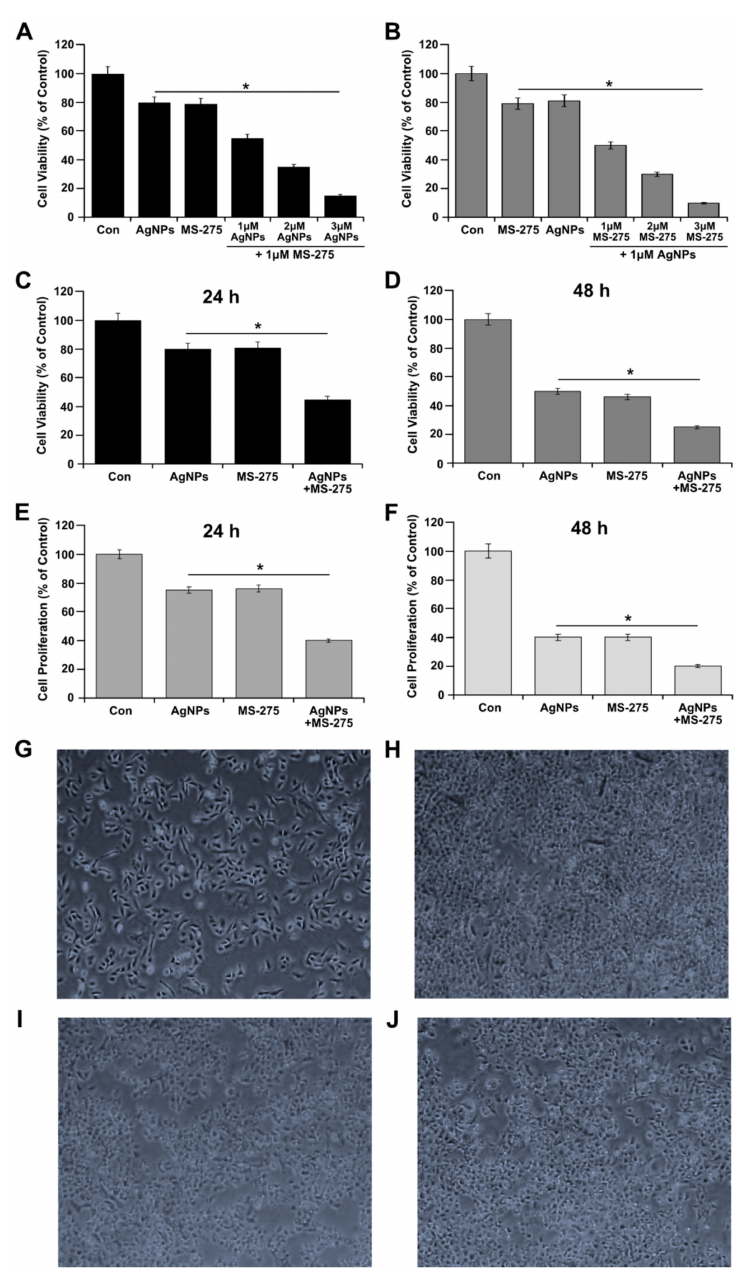
Figure 4. Effect of combination of AgNPs and MS-275 on cell viability in A549 cells. ( A ) A549 cells were incubated with a combination of different concentrations of AgNPs (1–3 µ M) and a fixed concentration of MS-275 (1 µ M) for 24 h and cell viability was measured using CCK-8. ( B ) A549 cells were incubated with a combination of different concentrations of MS-275 (1–3 µ M) and a fixed concentration of AgNPs (1 µ M) for 24 h. ( C , D ) Cell viability and ( E , F ) cell proliferation was determined in A549 cells were incubated with AgNPs (1 µ M), MS-275 (1 µ M), or a combination of AgNPs (1 µ M) and MS-275 (1 µ M). ( G – J ) Cell morphology was assessed under a light microscope. (G-control; H-AgNPs; I-MS-275; J-AgNPs; and MS-275). The results are expressed as the mean ± standard deviation of three separate experiments. Differences between the treated and control groups were measured using Student’s t -test. Statistically significant differences between the treated and control group are indicated by (* p <